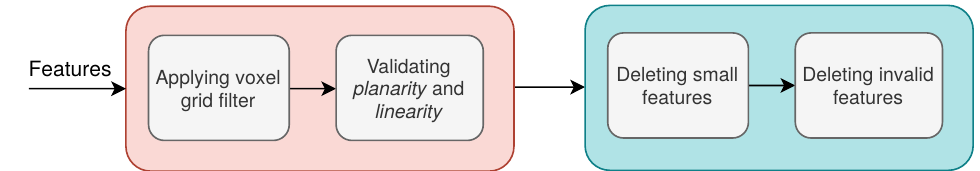
Figure 7. Steps performed to update existing features and delete too small or invalid